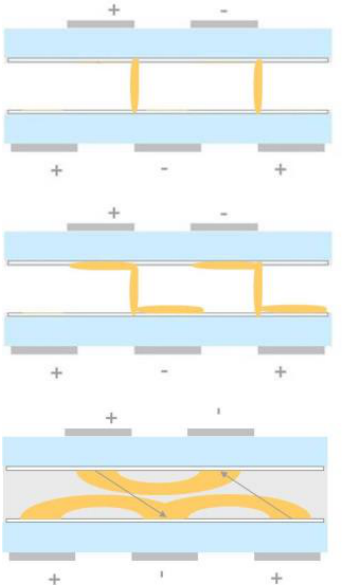
Figure 10. A schematic of the principle of complementary coplanar geometry. The three stages of the development of the discharge in orange. The last case requires higher voltages than those available with our power supply, so this case was never observed. (based on experimental observations).